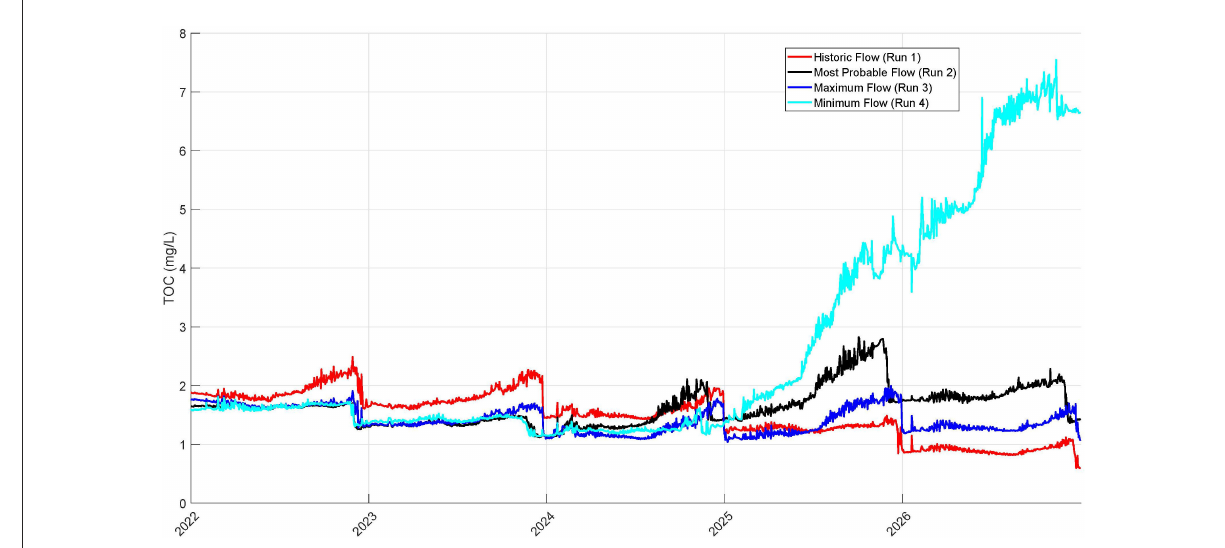
FIGURE9 Projected raw water TOC at Intake